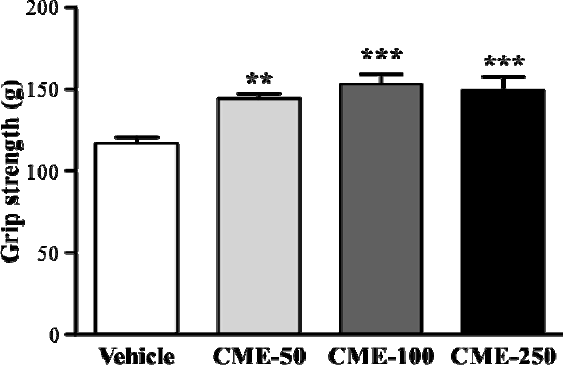
Figure 2. Effect of C. moschata extract (CME) supplementation on forelimb grip strength. Male ICR mice were pre-treated with vehicle, 50, 100, and 250 mg/kg ethanol extract of C. moschata (CME-50, CME-100, and CME-250) for 14 days, and underwent a grip strength test after 1 h of last administration. Data are presented as mean ± SEM of 8 mice in each group. ** p < 0.01; *** p < 0.001 compared to vehicle control.